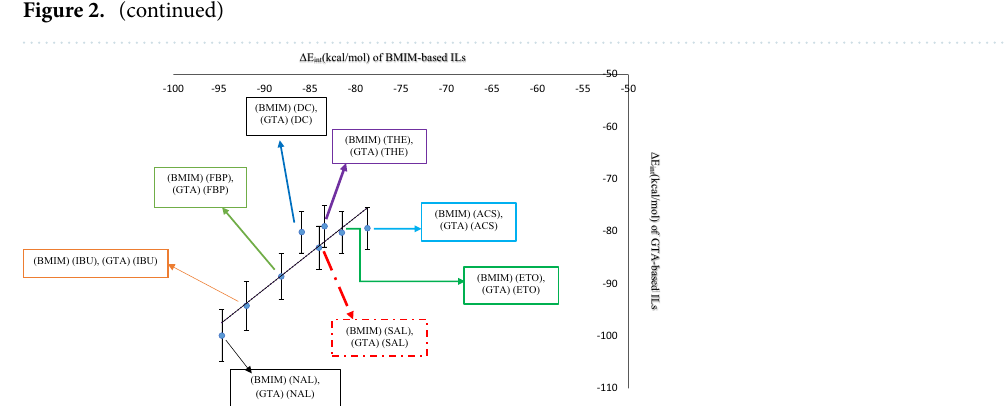
Figure 3. ΔE int values (kcal mol −1 ) of GTA-based ILs versus ΔE int values of BMIM-based Ils (error bar% =